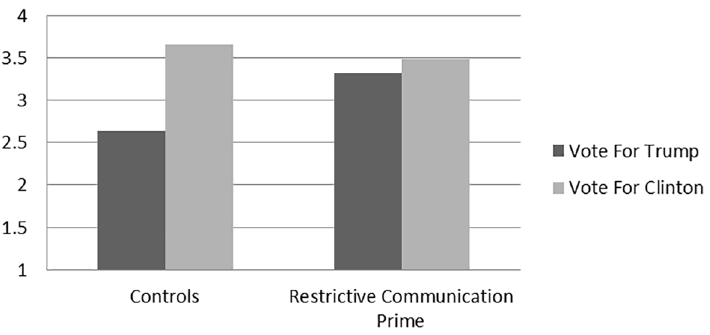
Figure 1. Voting likelihood for Trump and Clinton by restrictive communication